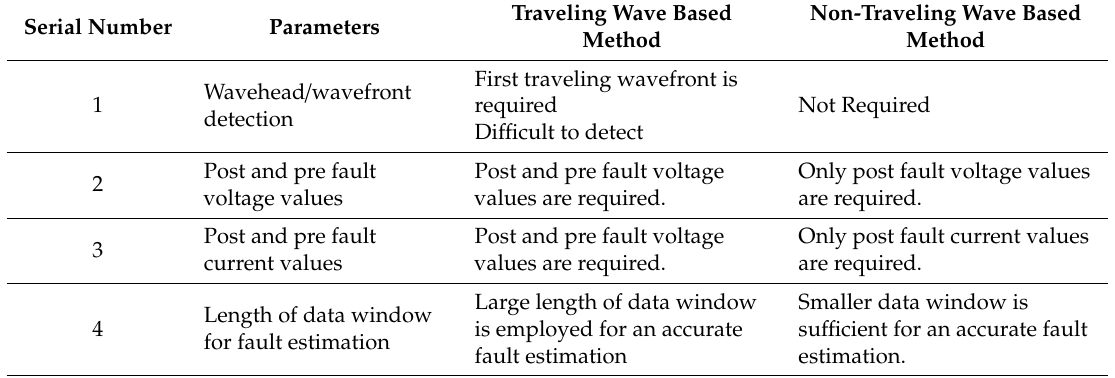
Comparison of traveling and non-traveling wave-based methods for multi-terminal high-voltage direct current (MT–HVdc) transmission